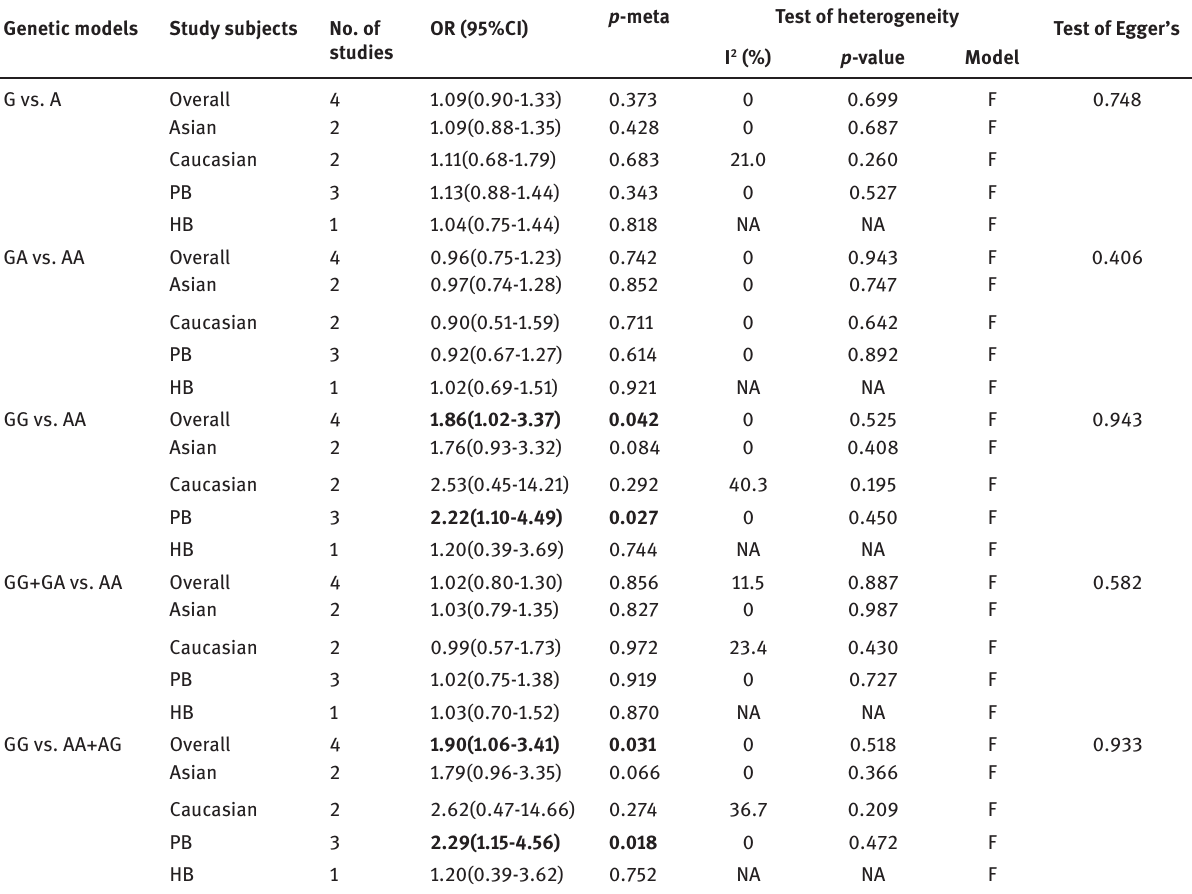
Table 4 : Summary ORs and 95%CI of the association between A2756G polymorphism and Parkinson disease susceptibility.